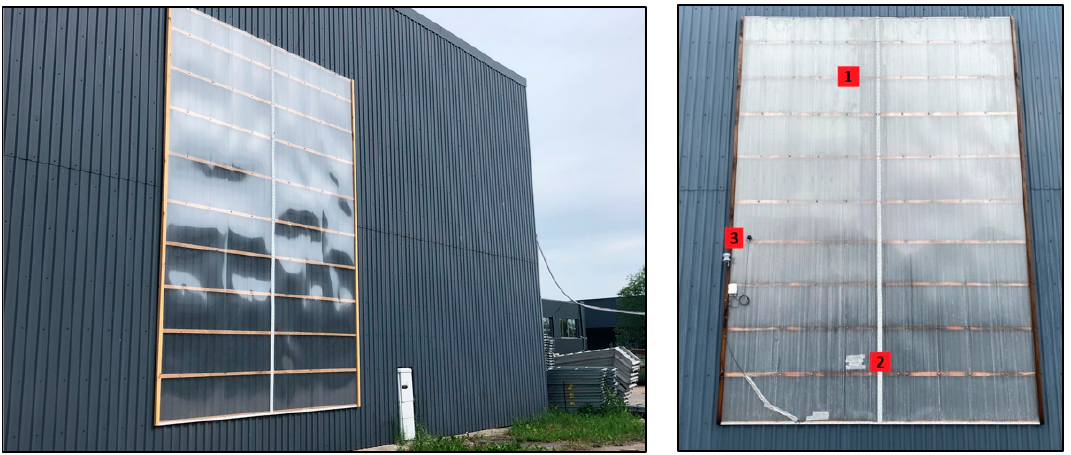
Figure 3. A Trombe wall structure installed onto a factory building in Kalnciems,